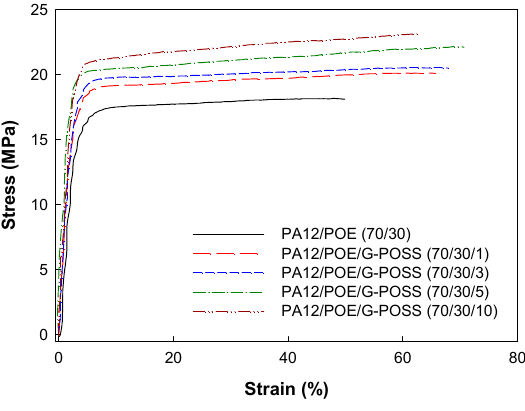
Figure 4. Stress–strain curves of samples. Table 1. Tensile properties and Izod impact strength of samples.